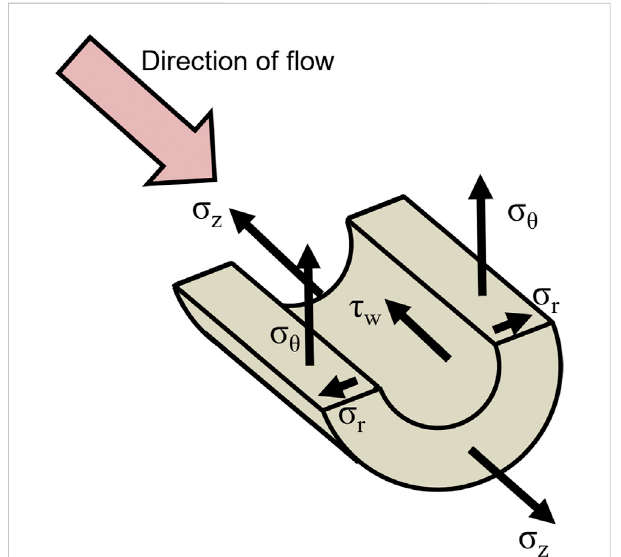
FIGURE 2 Blood pressure and fl ow in an artery yields the three primary loads acting on the vessel wall: pressure-induced circumferential wall stress σ θ , axial load-induced longitudinal wall stress σ z and fl ow- induced wall shear stress τ w . Radial wall stress σ r is small compared to the circumferential and longitudinal stresses and is neglected in this study. Note, arrows are only schematic, no correlation with magnitude intended.